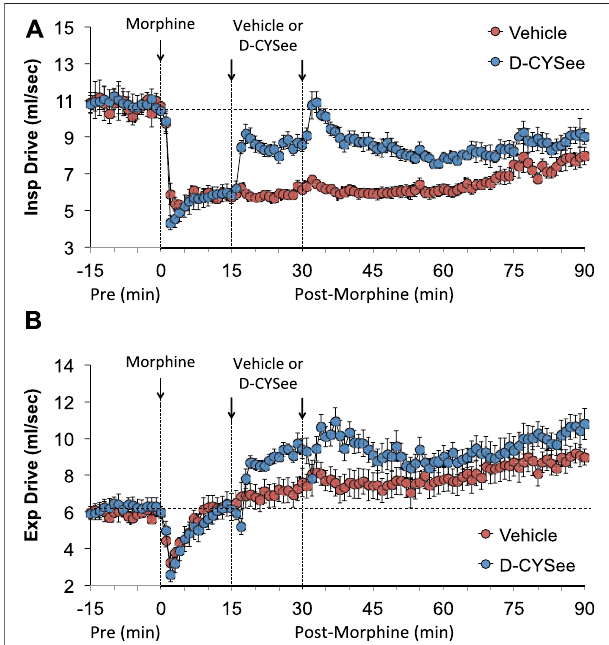
FIGURE 4 | Calculated values of inspiratory drive (TV/Ti) (Panel (A) ) and expiratory drive (TV/Te) (Panel (B) ) in freely moving rats prior to (pre) and following injection of morphine (10 mg/kg, IV) and subsequent injections of vehicle(saline)orD-cysteineethylester(D-CYSee,500 μ mol/kg,IV).The dataarepresentedasmean±SEM.Therewere5ratsinthevehiclegroupand 6 rats in the D-CYSee group.